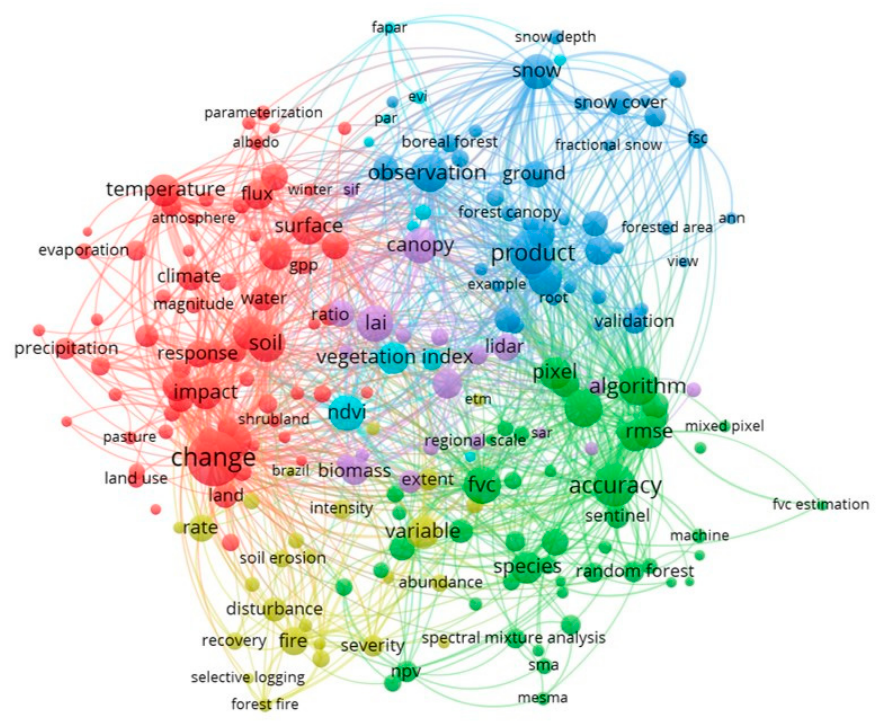
Figure 8. VOSviewer visualisation (WoS database) of a term co-occurrence network based on title and abstract